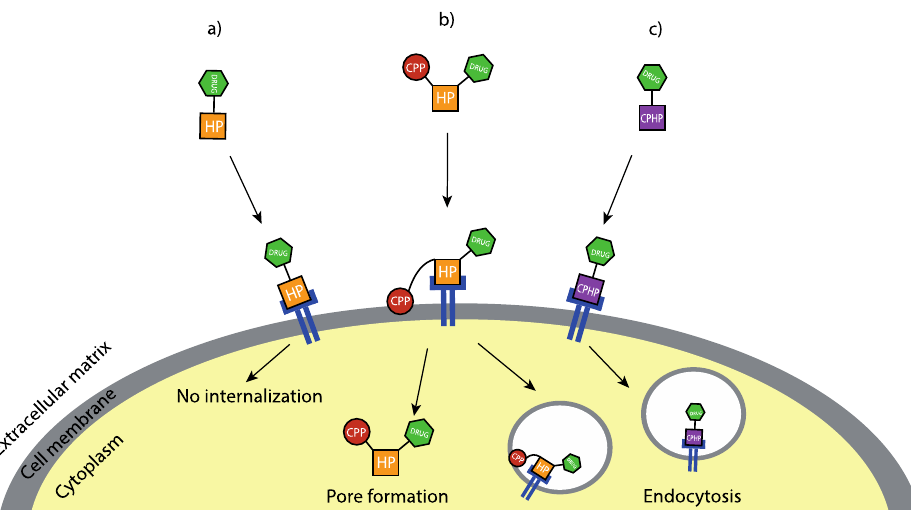
Figure 30. A representation of the three mechanisms of action of HP ( a ), CPP linked to an HP ( b ), CPHP ( c ).